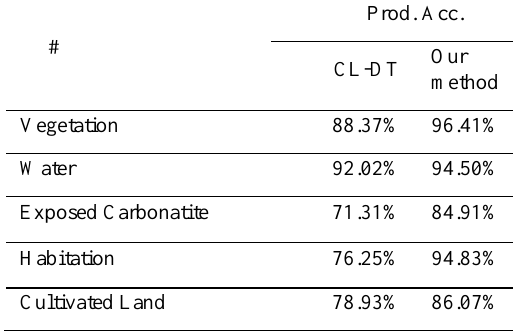
Table 1. Result data